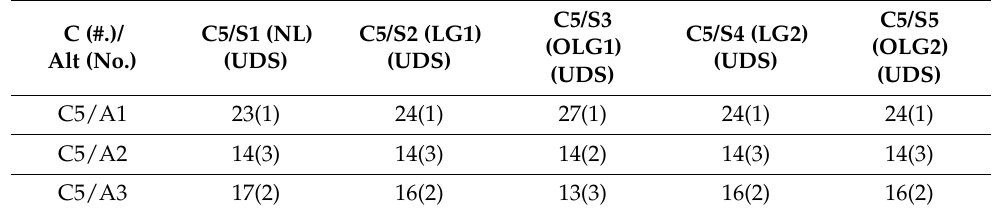
Table 24. MCDM evaluations analysis in Case 5 (C5/S1–S5) in terms of UDS for extended 75-bus MCMG.